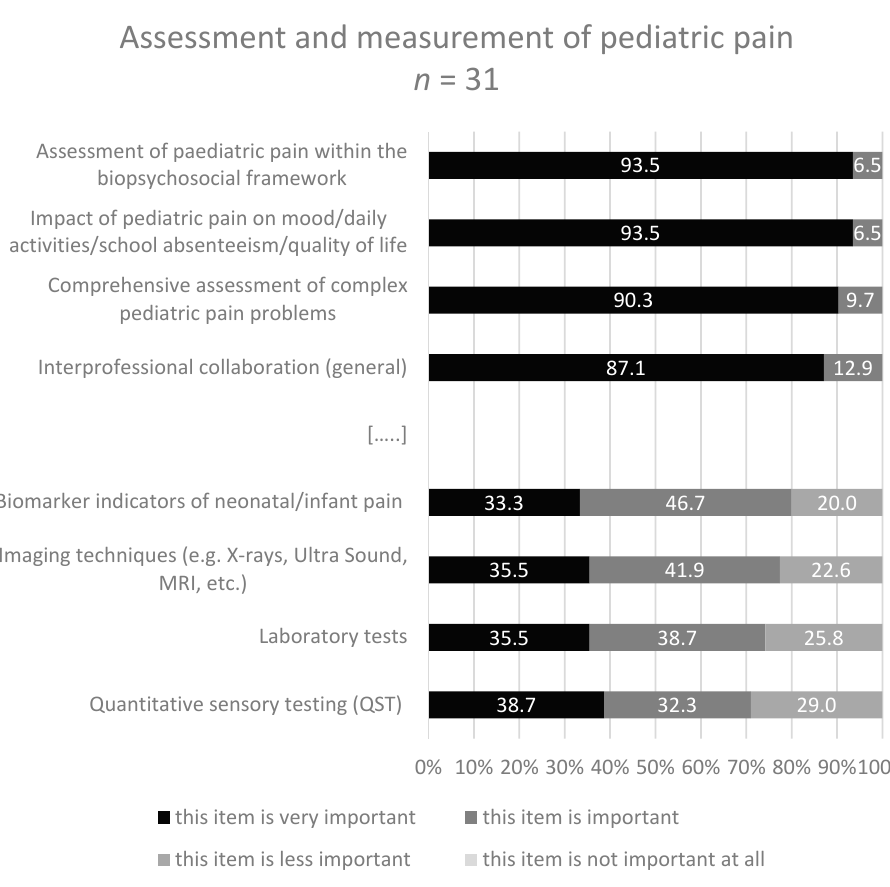
Figure 4. Response categories with highest/lowest accordance in area 2 (Assessment). […..]: omission of items in the medium range